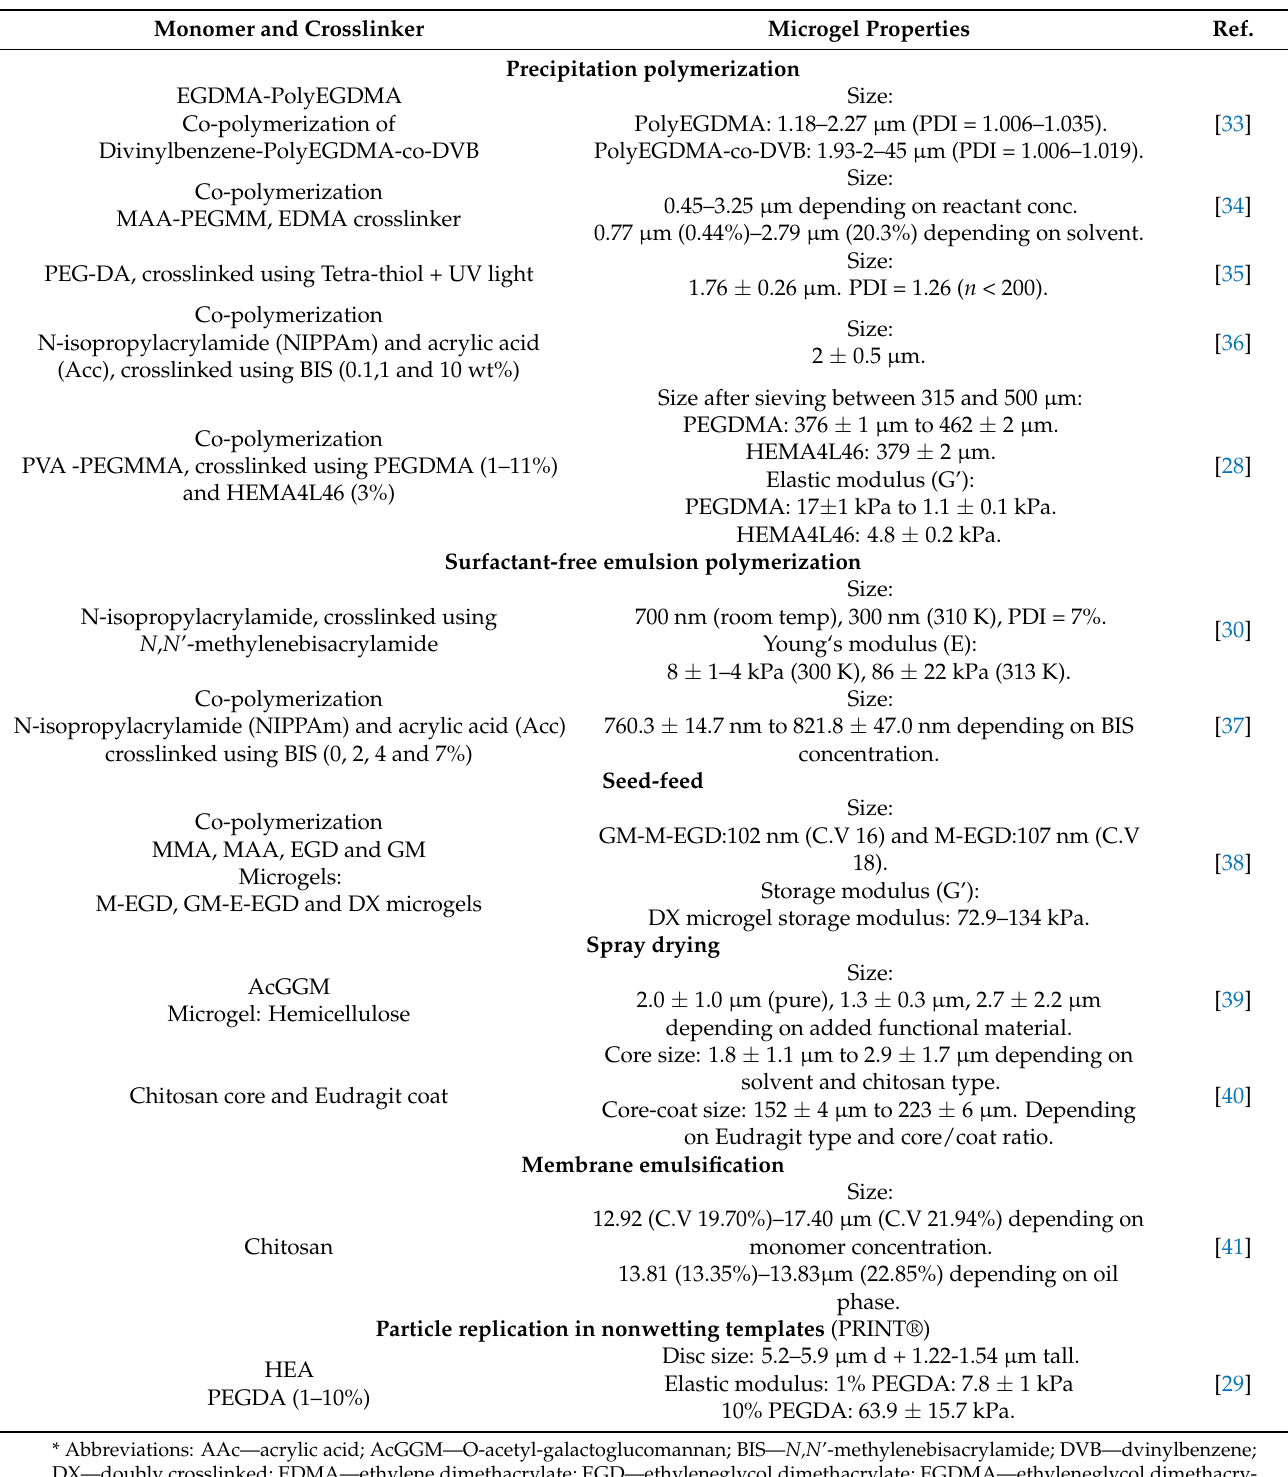
Table 1. Examples of bulk fabrication strategies to prepare microgels